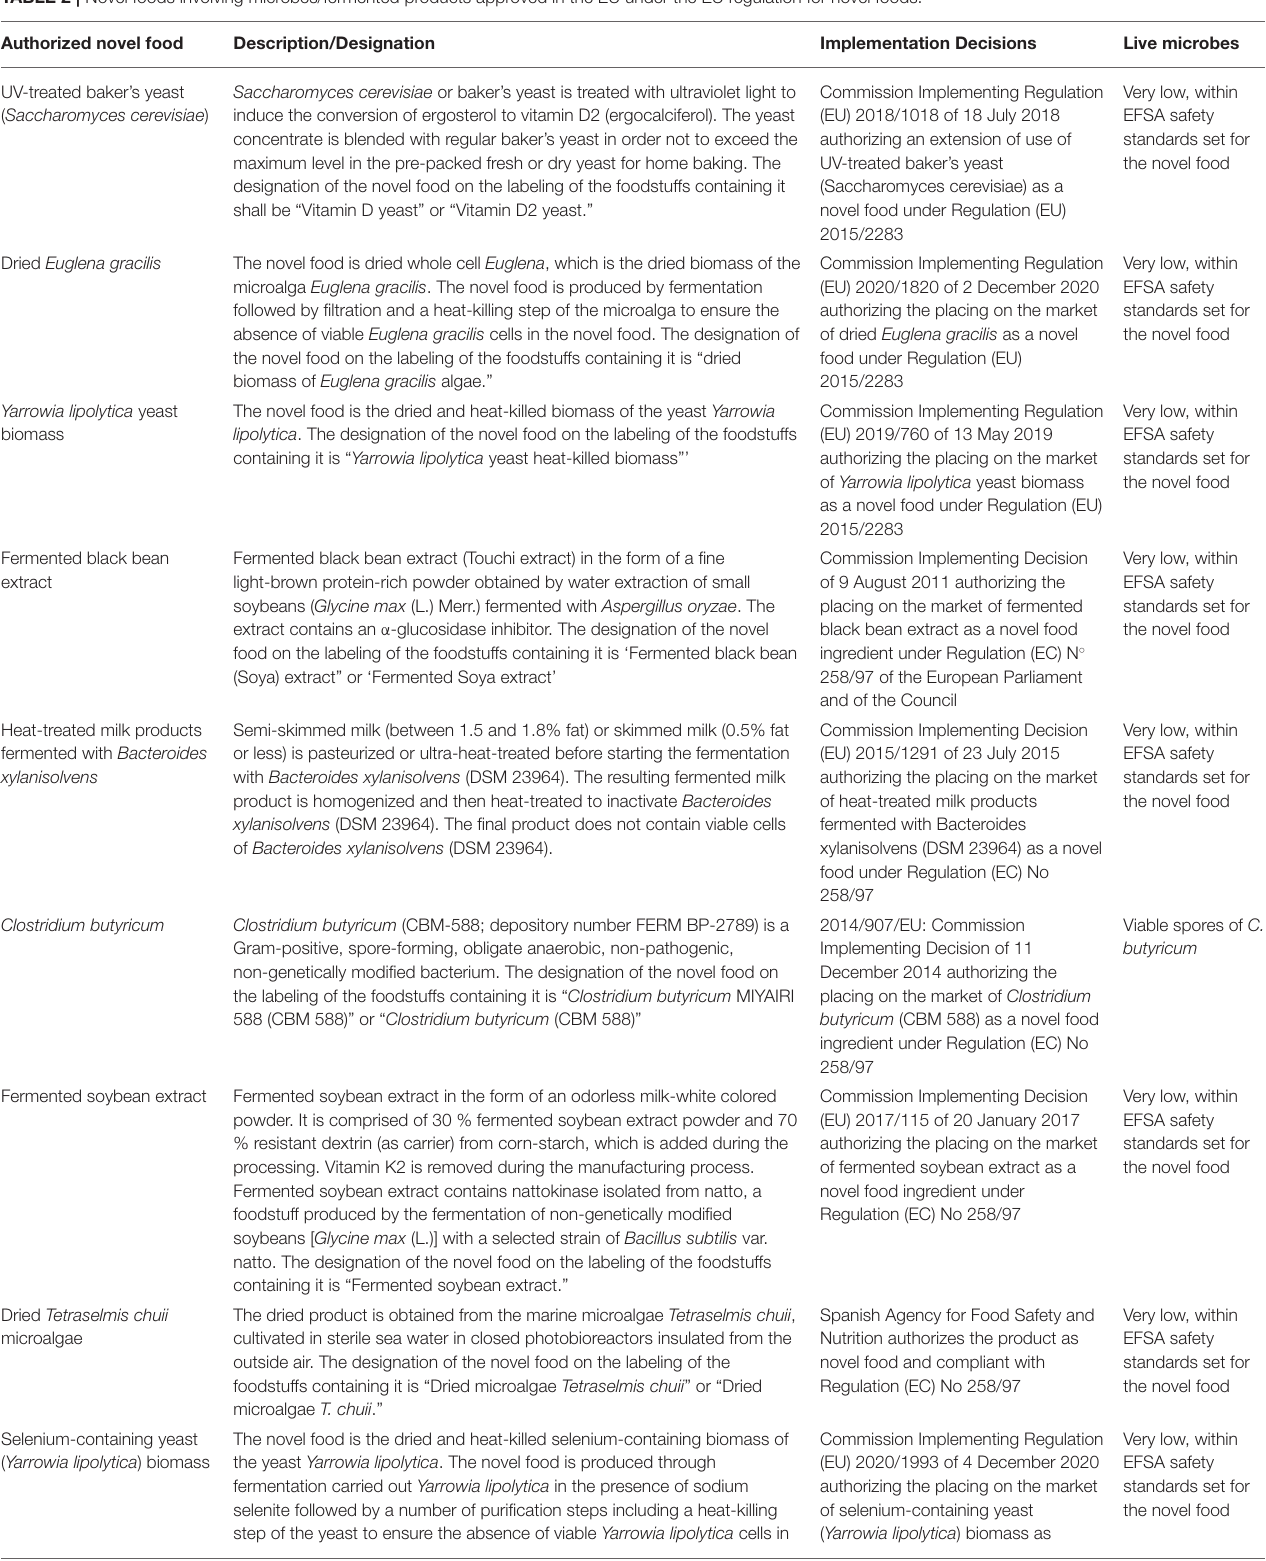
TABLE 2 | Novel foods involving microbes/fermented products approved in the EU under the EU regulation for novel